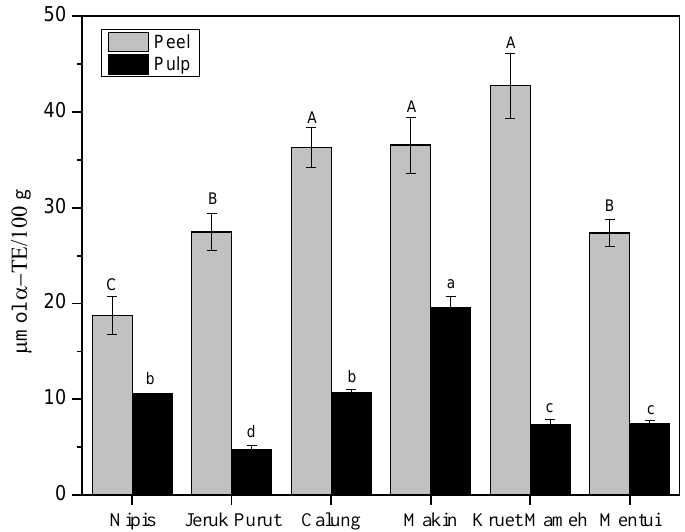
Figure 4. L-TEAC values ( µ mol α -TE/100 g) of 50% MeOH/THF extracts of peels and pulps of citrus samples. Values are expressed as mean ± SD ( n = 3). Bars with different letters are significantly different (One Way ANOVA, Tukey HSD test, p < 0.05). Capital (A,B,C) and small (a,b,c) letters indicate the comparison done in its respective categories.